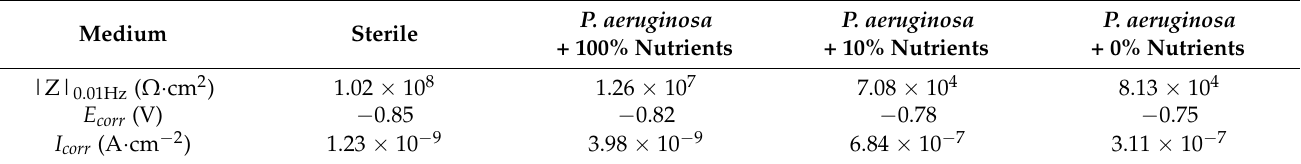
Figure 5. Polarization curves of the samples after 14 days of immersion in the sterile culture medium and the P. aeruginosa − inoculated culture media with 100%, 10%, and 0% nutrients. Table 1. Electrochemical corrosion parameters determined from the EIS and polarization curves after 14 days of immersion.